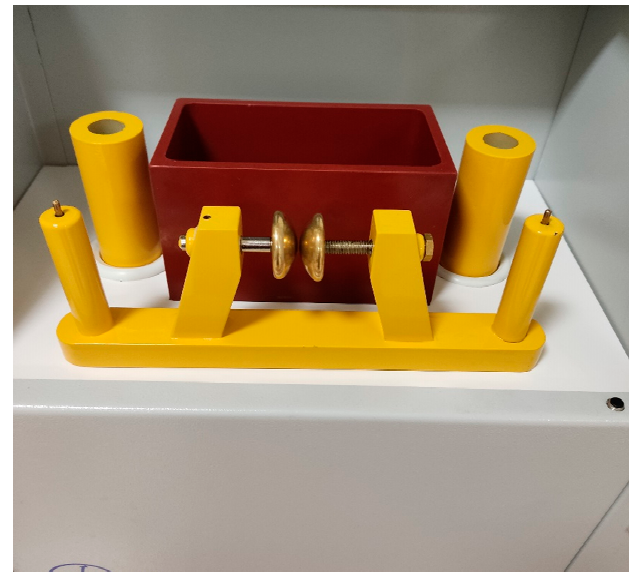
Figure 5. Spherical electrodes in an empty tank.